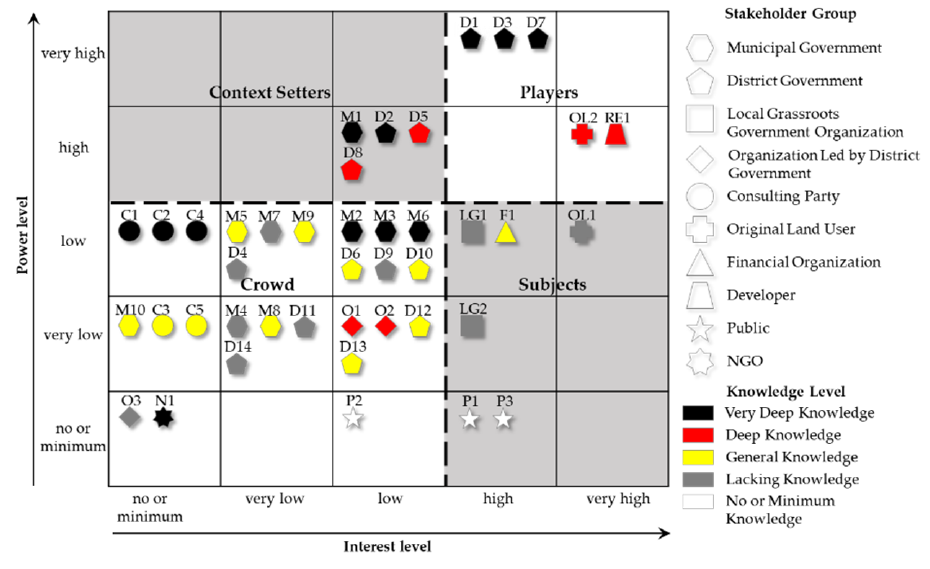
Figure 3. Power vs. interest grid, grouped based on ( a ) stakeholder groups and type of interest, ( b ) stakeholder groups and knowledge level.